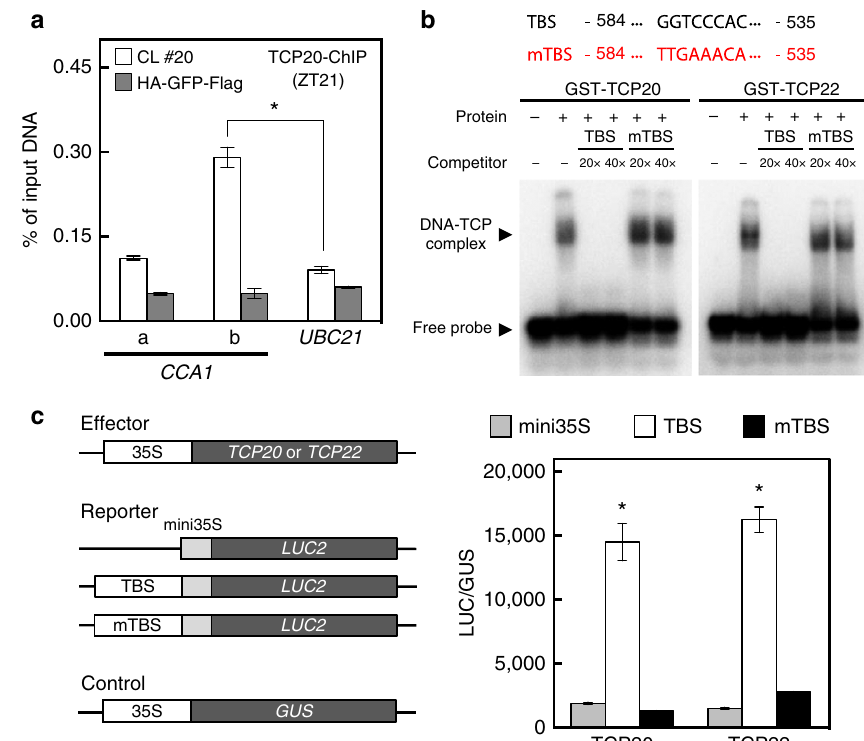
Figure 4 | TCP20/TCP22 bind to the TCP-binding site (TBS) for CCA1 activation. ( a ) TCP20 associates with the TBS-containing region of CCA1 promoter in vivo . ChIP assays involved use of the anti-Flag antisera with tcp20-2 pTCP20::TCP20-Flag pCCA1::LUC2 complementation line (CL #20) or